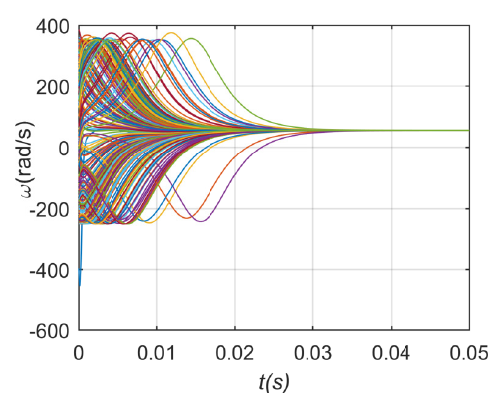
Figure 9. Frequency stabilization process of directed network in case 1.